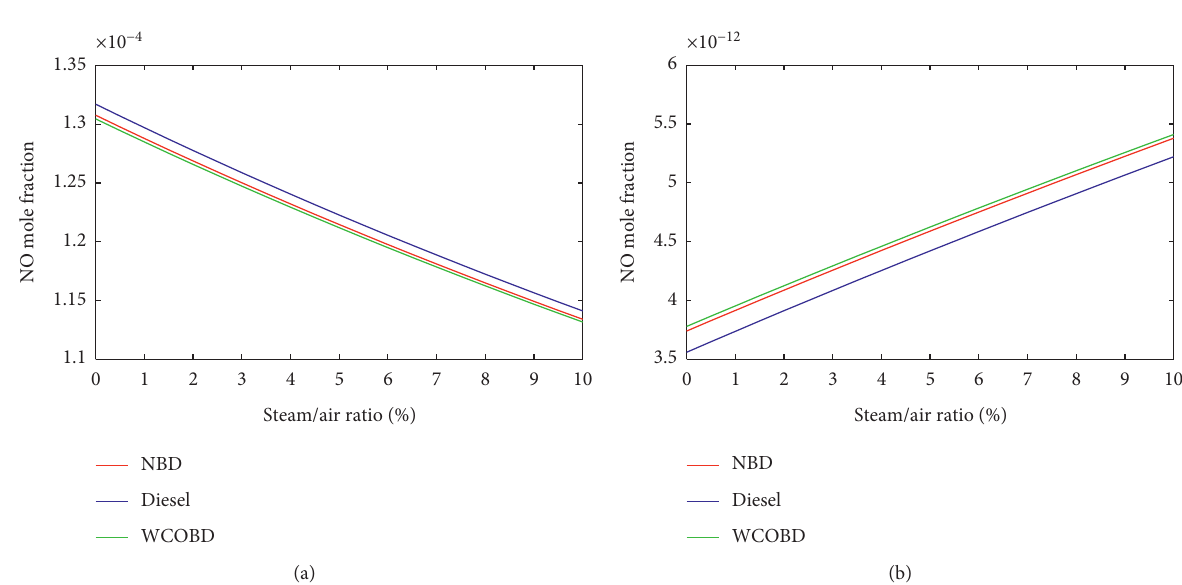
Figure 10: Variation of NO equilibrium mole fractions with steam injection